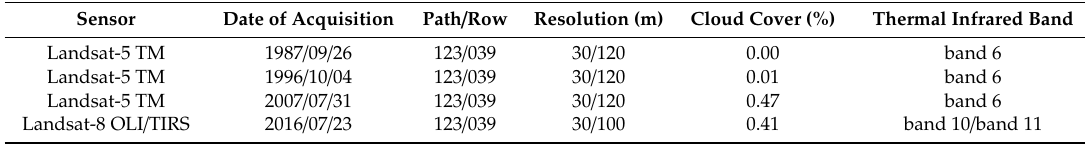
Table 1. Data details of the Landsat images used in this